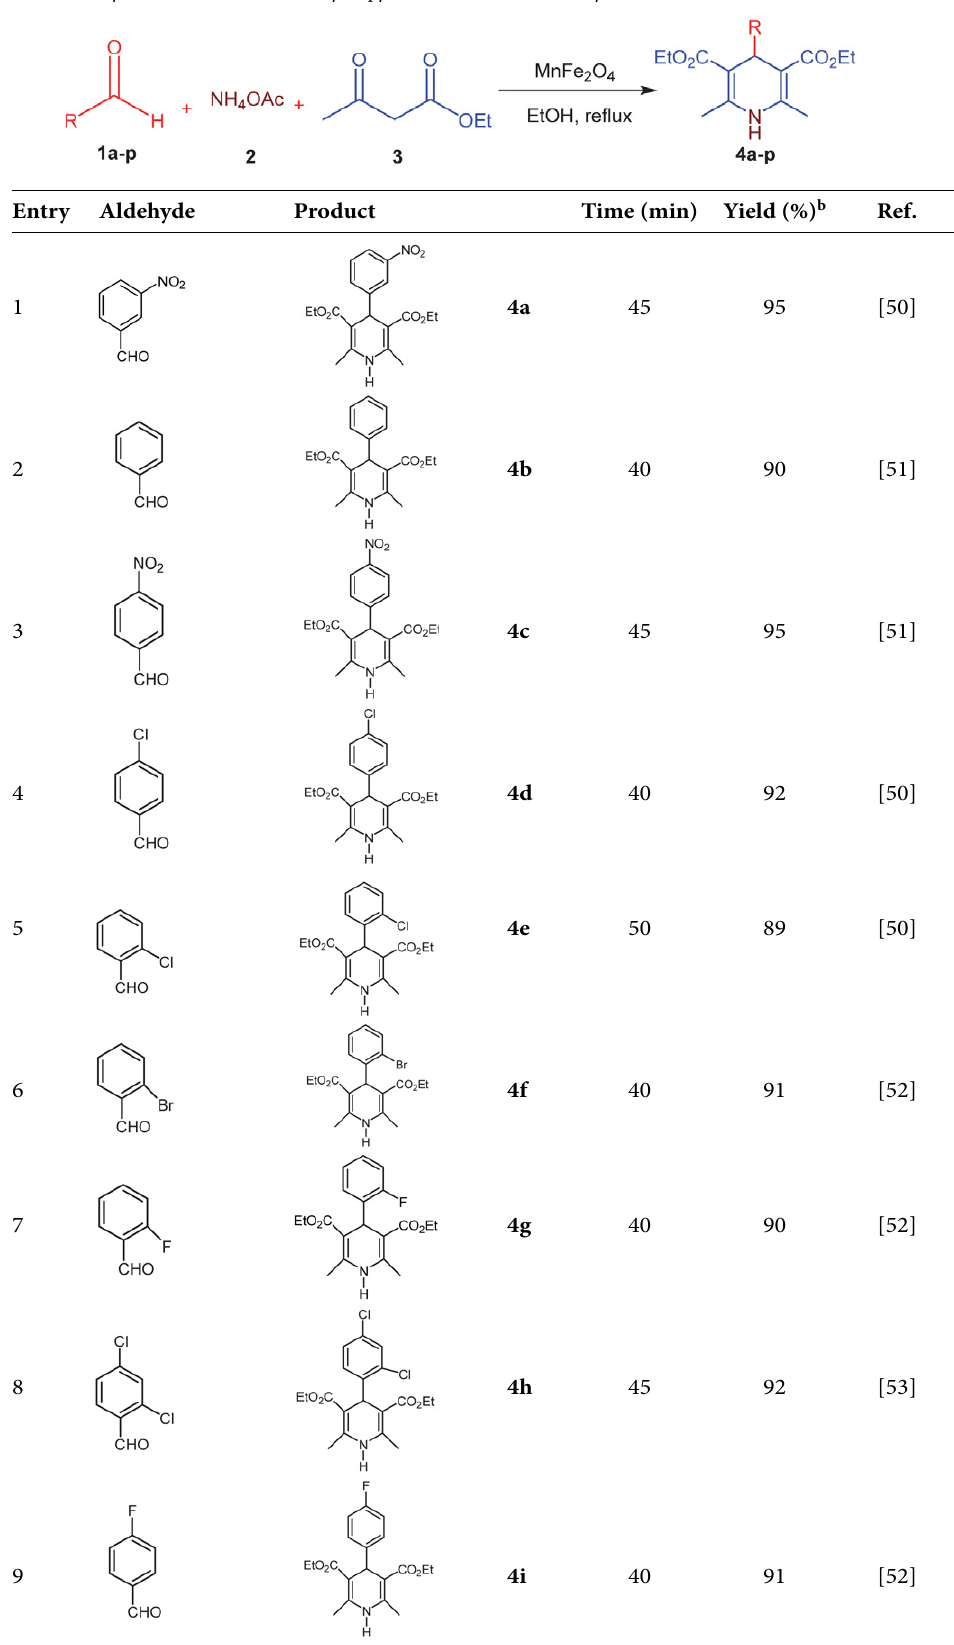
Table 2. Synthesis of different 1,4-dihydropyridines from several